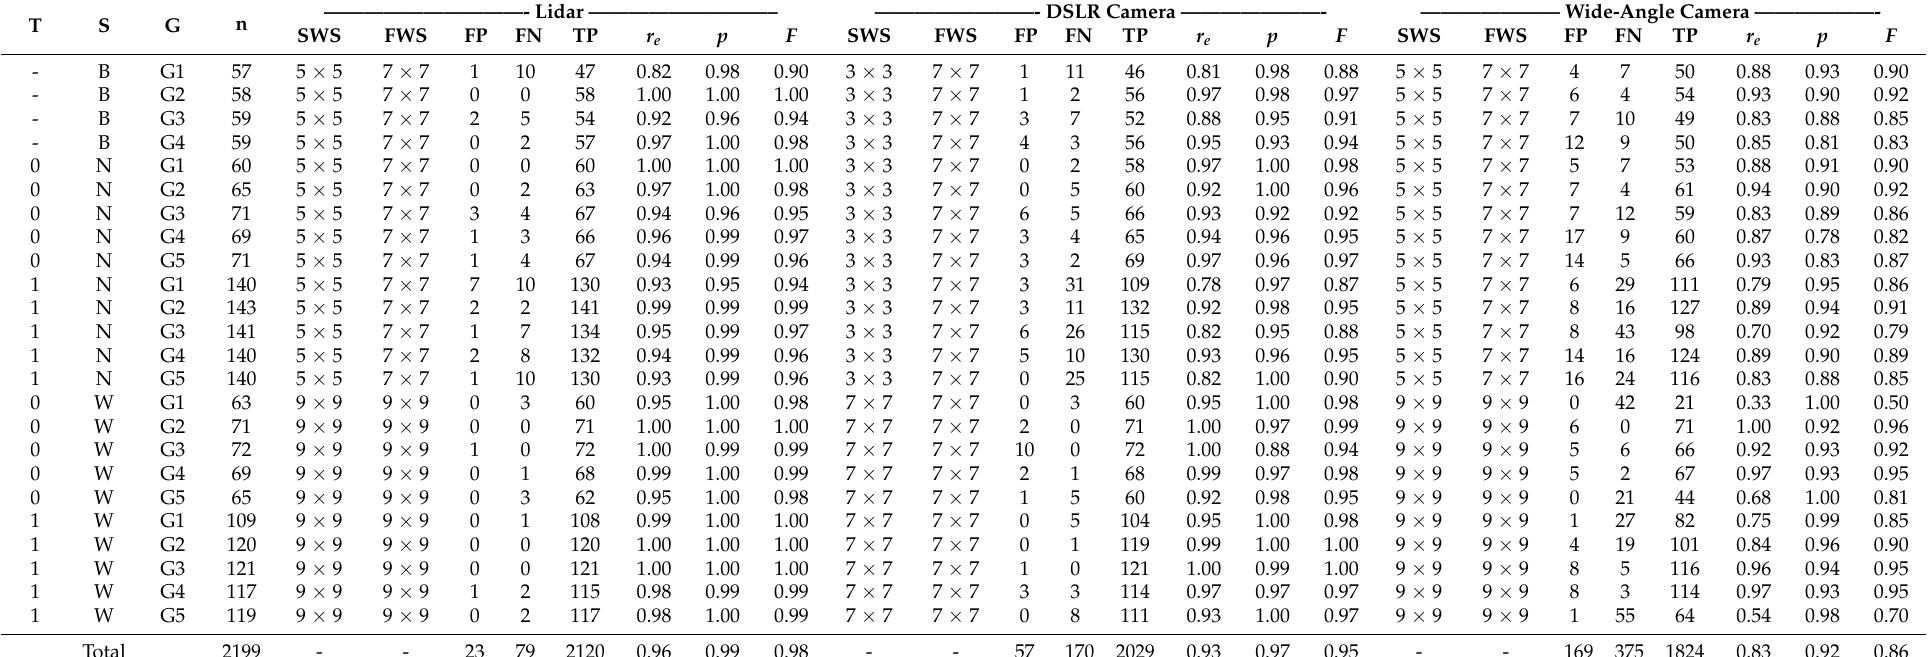
Table 3. Accuracy assessment results of lidar, DSLR and wide-angle automated individual tree detection based on false positive (FP), false negative (FN), true positive (TP), recall ( r e ), precision ( p ) and F-score ( F )